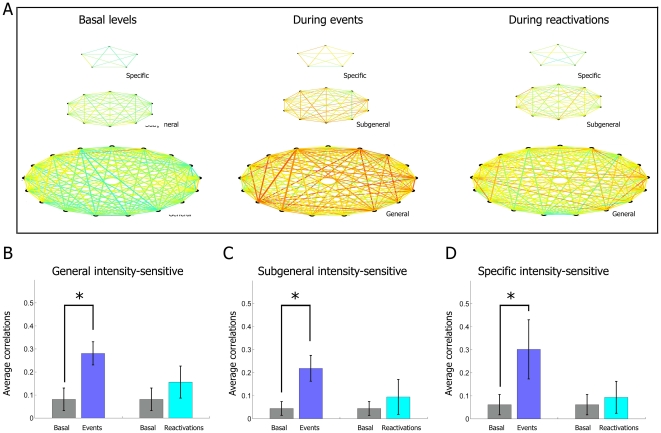
Cross-correlation analysis of the intensity-modulated
subpopulation.(A) Correlations between top representative
intensity-modulated units from mouse #1 encoding a specific type of
event (top row), subgeneral features (multiple but not all types, second
row), and general features (response to all types of events, third row),
are displayed as colored lines during basal activity periods (first
column), the actual event periods (second column) and at the time of
reactivations (third column). High and low correlations are plotted with
red and blue lines, respectively. (B) While the
correlations increase significantly for the general-encoding and
intensity-sensitive subpopulation during the startle episodes, these
correlations return to values that are close to the baseline
correlations. This trend is also manifest for the (C)
subgeneral-encoding and intensity-sensitive and (D)
specific encoding and intensity-sensitive subpopulations.